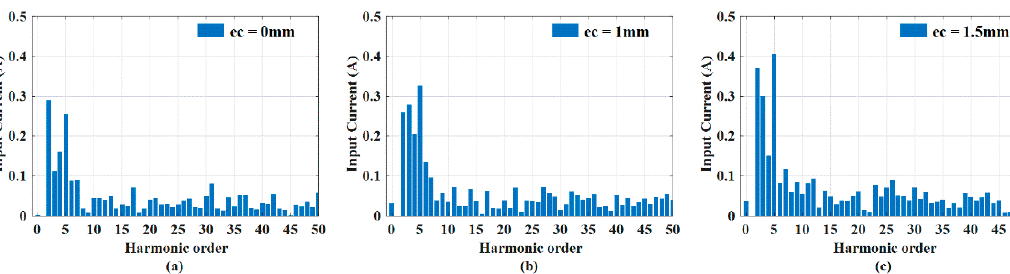
Figure 8. Experimental fast Fourier transform (FFT) results of input current: ( a ) ec = 0 mm, ( b ) ec = 1 mm, and ( c ) ec = 1.5 mm.